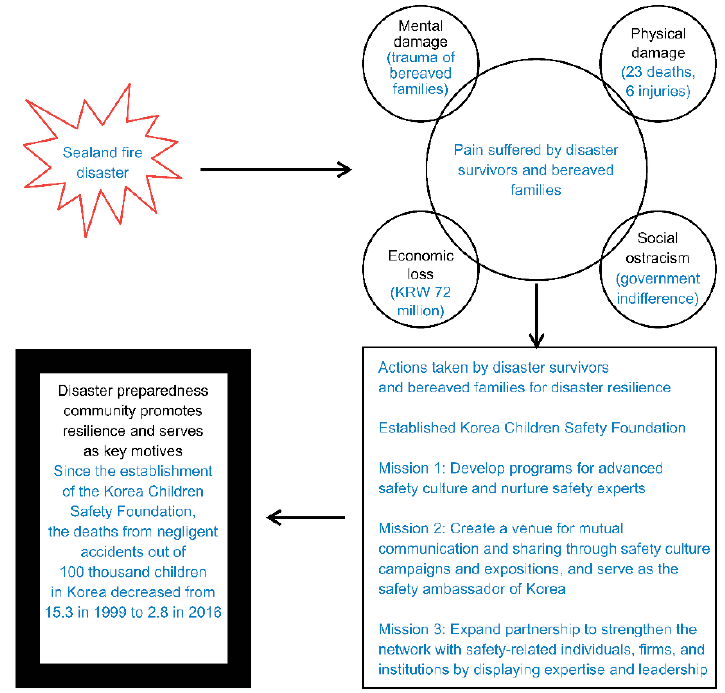
Figure 2. Disaster preparedness framework of disaster survivors and bereaved families for the Hwaesong Sealand fire.